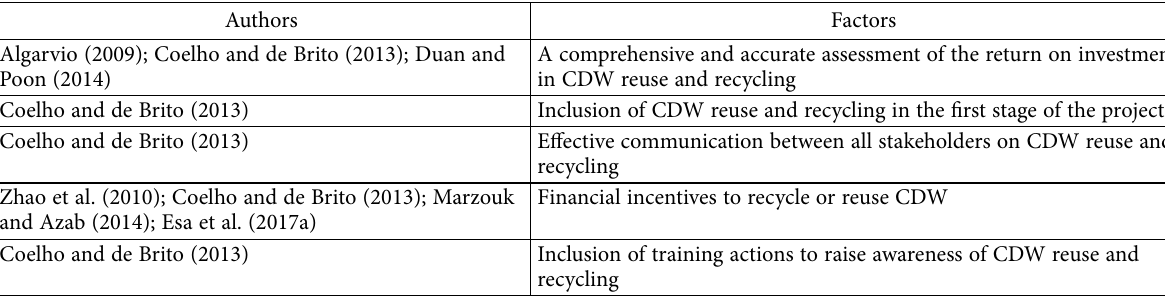
Table 3. Factors that promote the practice of CDW reuse and recycling